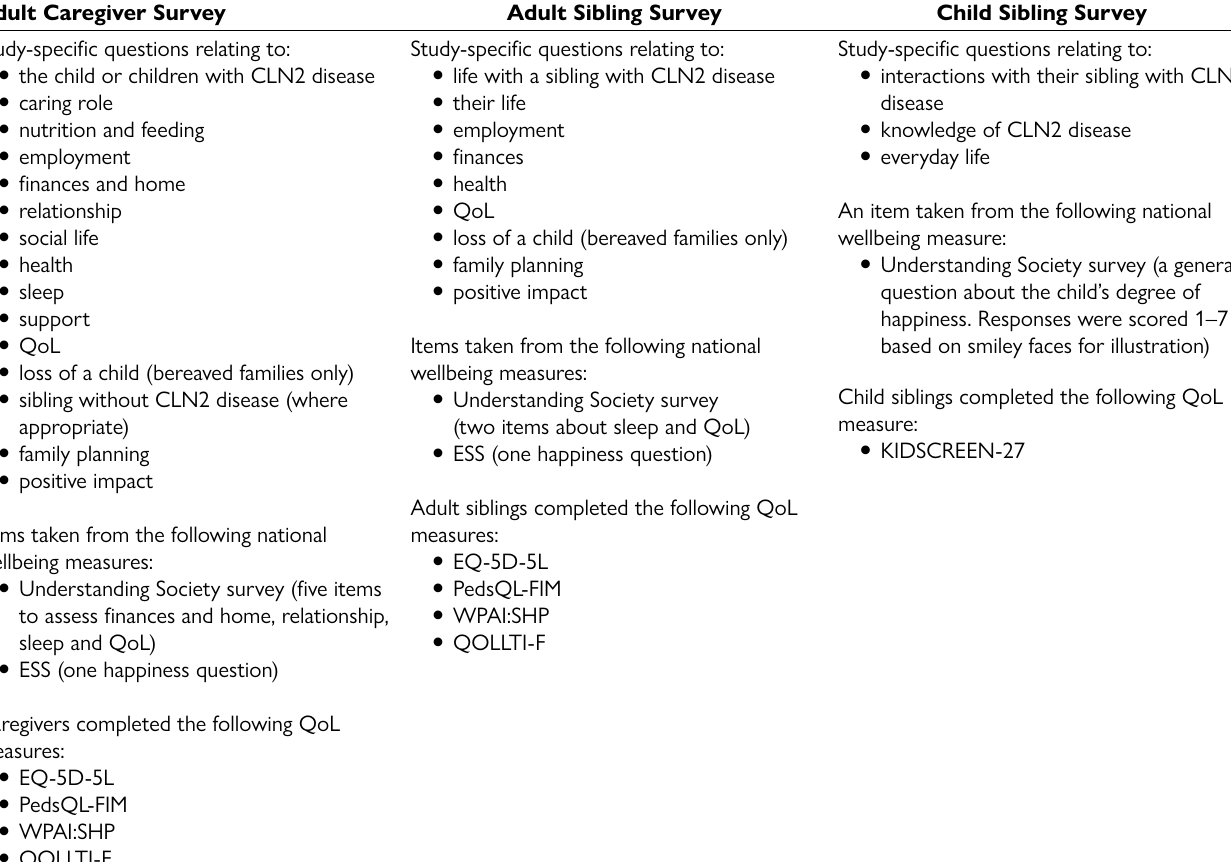
Table 1. Outline of survey